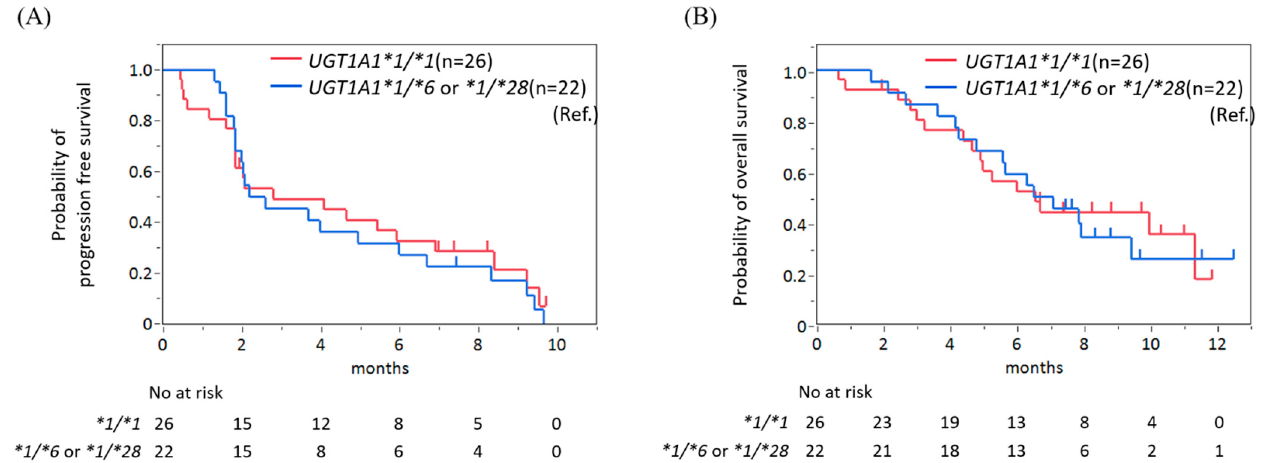
Figure 2. No significant difference in progression-free survival ( A ) and overall survival ( B ) was found between patients with wild-type UGT1A1 and those with single-heterozygous UGT1A1 . To correct for potential confounding factors that have an impact on survival outcomes, Table 6. Multivariate analysis for PFS and OS in UGT1A1 analysis set ( n = 48). we have also performed multivariate analysis with a Cox proportional hazard